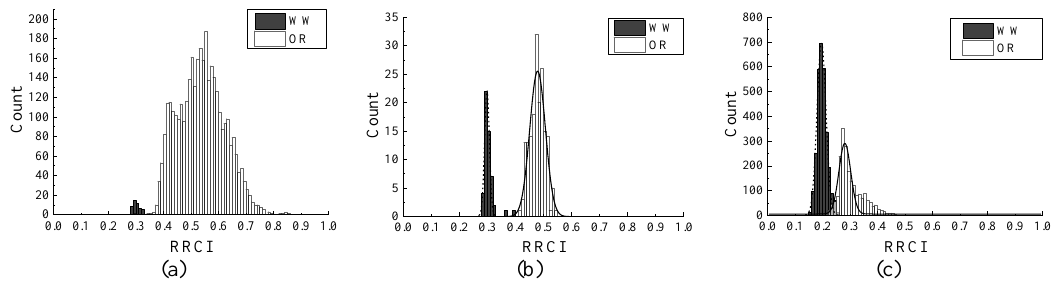
Figure 8. RRCI histogram of the 𝐻 𝑛𝑜𝑟𝑚 -V space of ( a ) part 1 (V ≥ 0.07 and 𝐻 𝑛𝑜𝑟𝑚 ≤ 0.25); ( b ) part 2 (V ≥ 0.12 and 0.25 < 𝐻 𝑛𝑜𝑟𝑚 ≤ 0.42); and ( c ) part 3 (0.07 ≤ V < 0.12 and 0.25 < 𝐻 𝑛𝑜𝑟𝑚 ≤ 0.42) for OR and WW. ISPRS Int. J. Geo-Inf. 2018 , 7 , x FOR PEER REVIEW